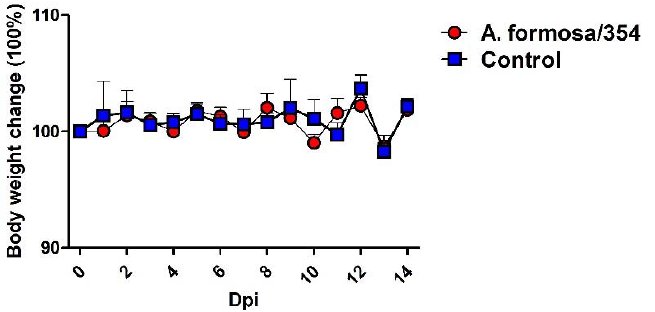
Figure 7. Body weight change in mice infected with H12 isolate from wild birds, Poyang Lake. Five-week-old BALB/c mice were infected with 10 5 EID 50 . The body weight of mice was observed over 14 dpi.